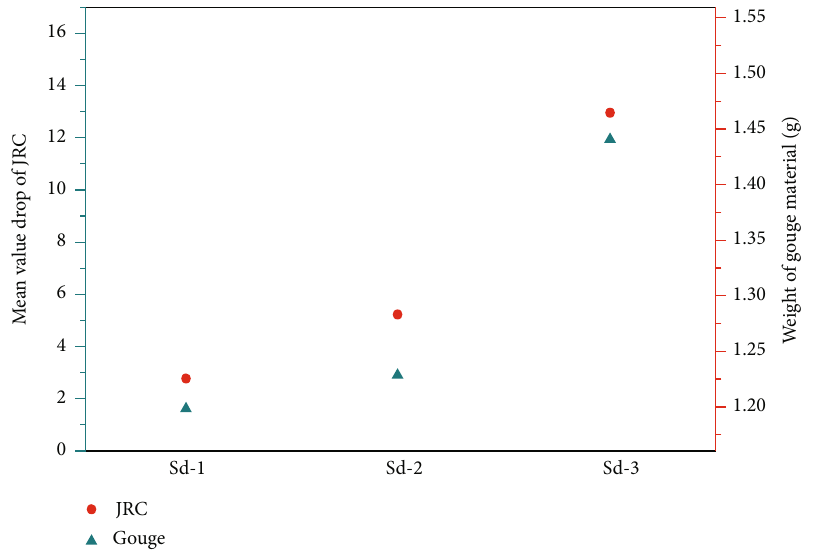
Figure 14: Mean value drop of JRC and weights of gouge material after testing under dynamic